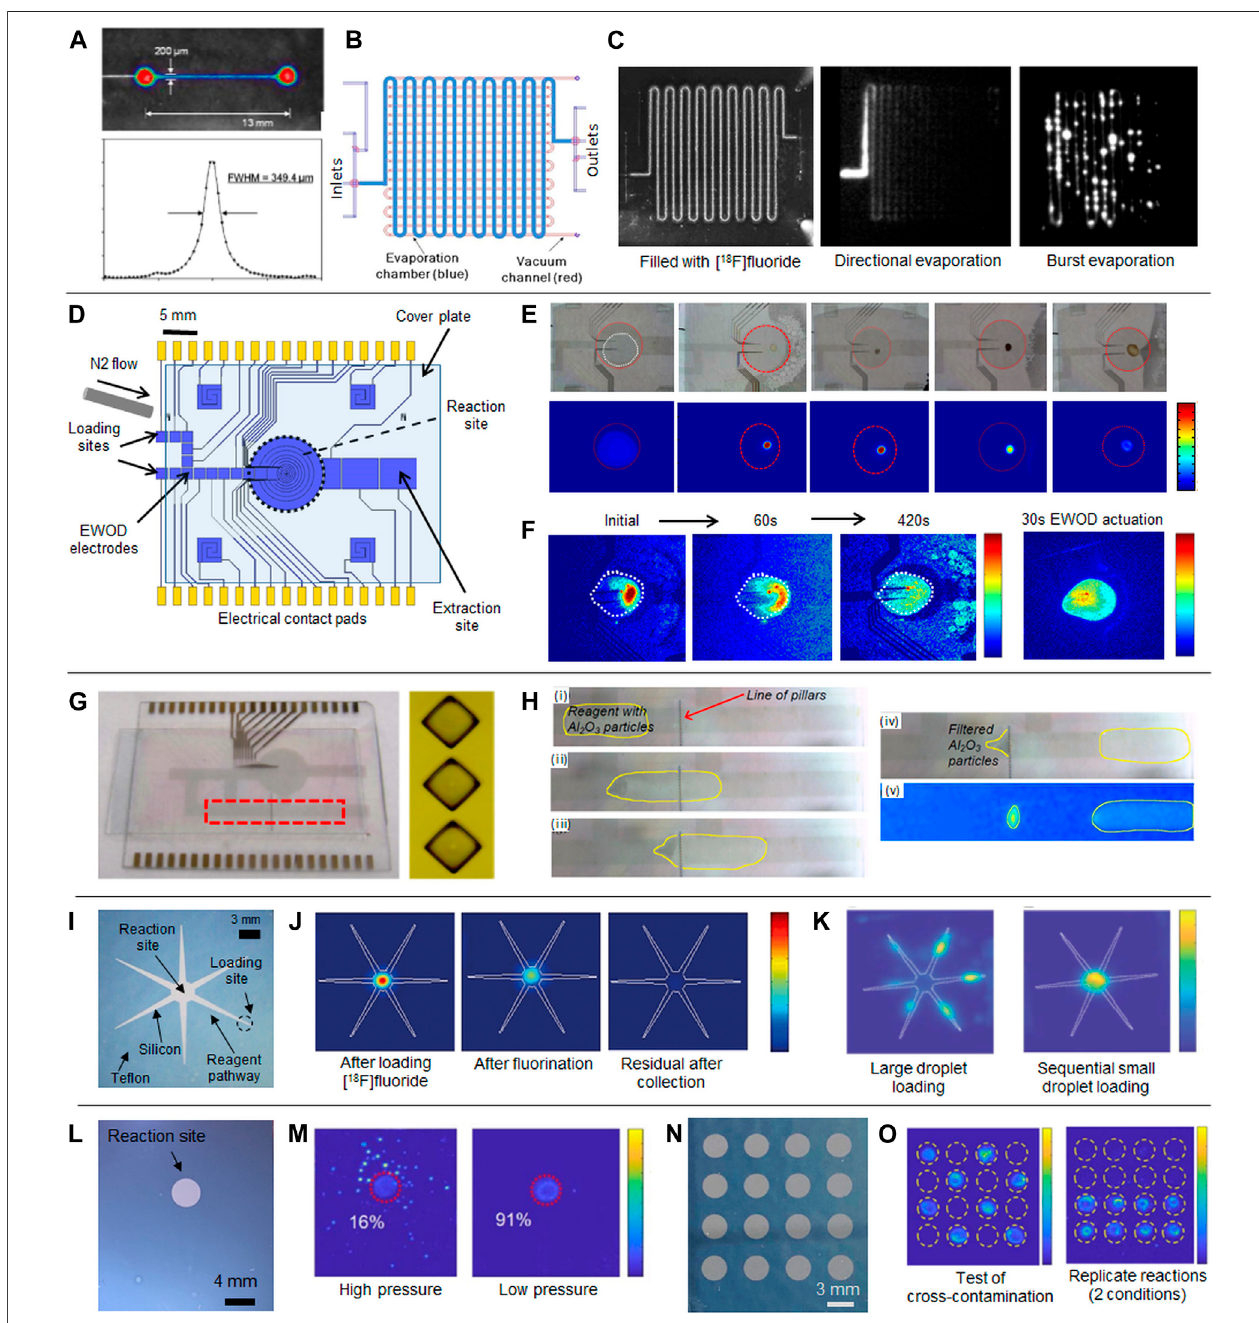
FIGURE1| UseofCerenkovimaginginthedevelopmentofmicro fl uidicsforradiopharmaceuticalproduction. (A) Top:Cerenkovimageofmicrochannelcontaining [ 18 F]FDG;Bottom:Linepro fi leofsignalintensityacrossthechannel.Adaptedfrom[2]bypermissionofIOPPublishing. © InstituteofPhysicsandEngineeringinMedicine. All rights reserved. (B) PDMS chip design for studying losses during [ 18 F] fl uoride drying. (C) Cerenkov images (without false coloring) after loading and sealing the chamber, and two possible patterns of radioactivity distribution after solvent evaporation ( “ directional ” and “ burst ” ). Adapted from [22]. (D) Diagram of EWOD radiosynthesis chip. (E) Optical (top row) and Cerenkov (bottom row) images after key steps in the synthesis of [ 18 F]FDG. (D,E) adapted from [34]. (F) Cerenkov images of radioactivity distribution in EWOD chip reaction site after a droplet of precursor solution was added to dried [ 18 F] fl uoride residue. Left 3 images show time sequence during passive diffusion at room temperature. Right image shows distribution after 30s of active mixing using electrodes. Adapted from [35] with permission fromtheRoyalSocietyofChemistry. (G) EWODchipwithintegrated fi lterforaluminabead-basedscavengingofunreacted[ 18 F] fl uoride. (H) Opticalimagesofchipatkey steps during the puri fi cation process and Cerenkov image of the retained beads and puri fi ed droplet in the fi nal state. (G,H) adapted, with permission, from [40], © IEEE. (I) Te fl on-siliconchipfordropletradiochemistrybasedonpassivetransport. (J) SuccessiveCerenkovimagesofthechipafterkeystepsinthesynthesisof[ 18 F]Fallypride. (I,J) adapted from [41] with permission from the Royal Society of Chemistry. (K) Cerenkov images of the chip after loading and drying 25 µl of concentrated [ 18 F] fl uoride